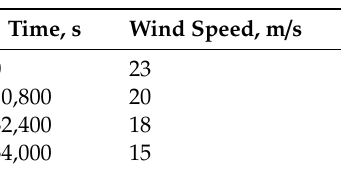
Table 3. Wind data.